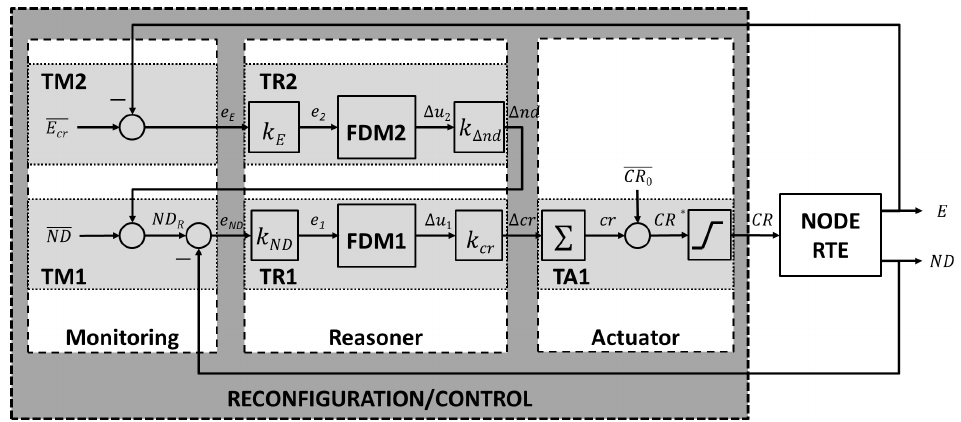
Figure 1. Control system design for self-adapting the Wireless Sensors Networks (WSN) nodes transmission power considering the number of neighbors and the battery